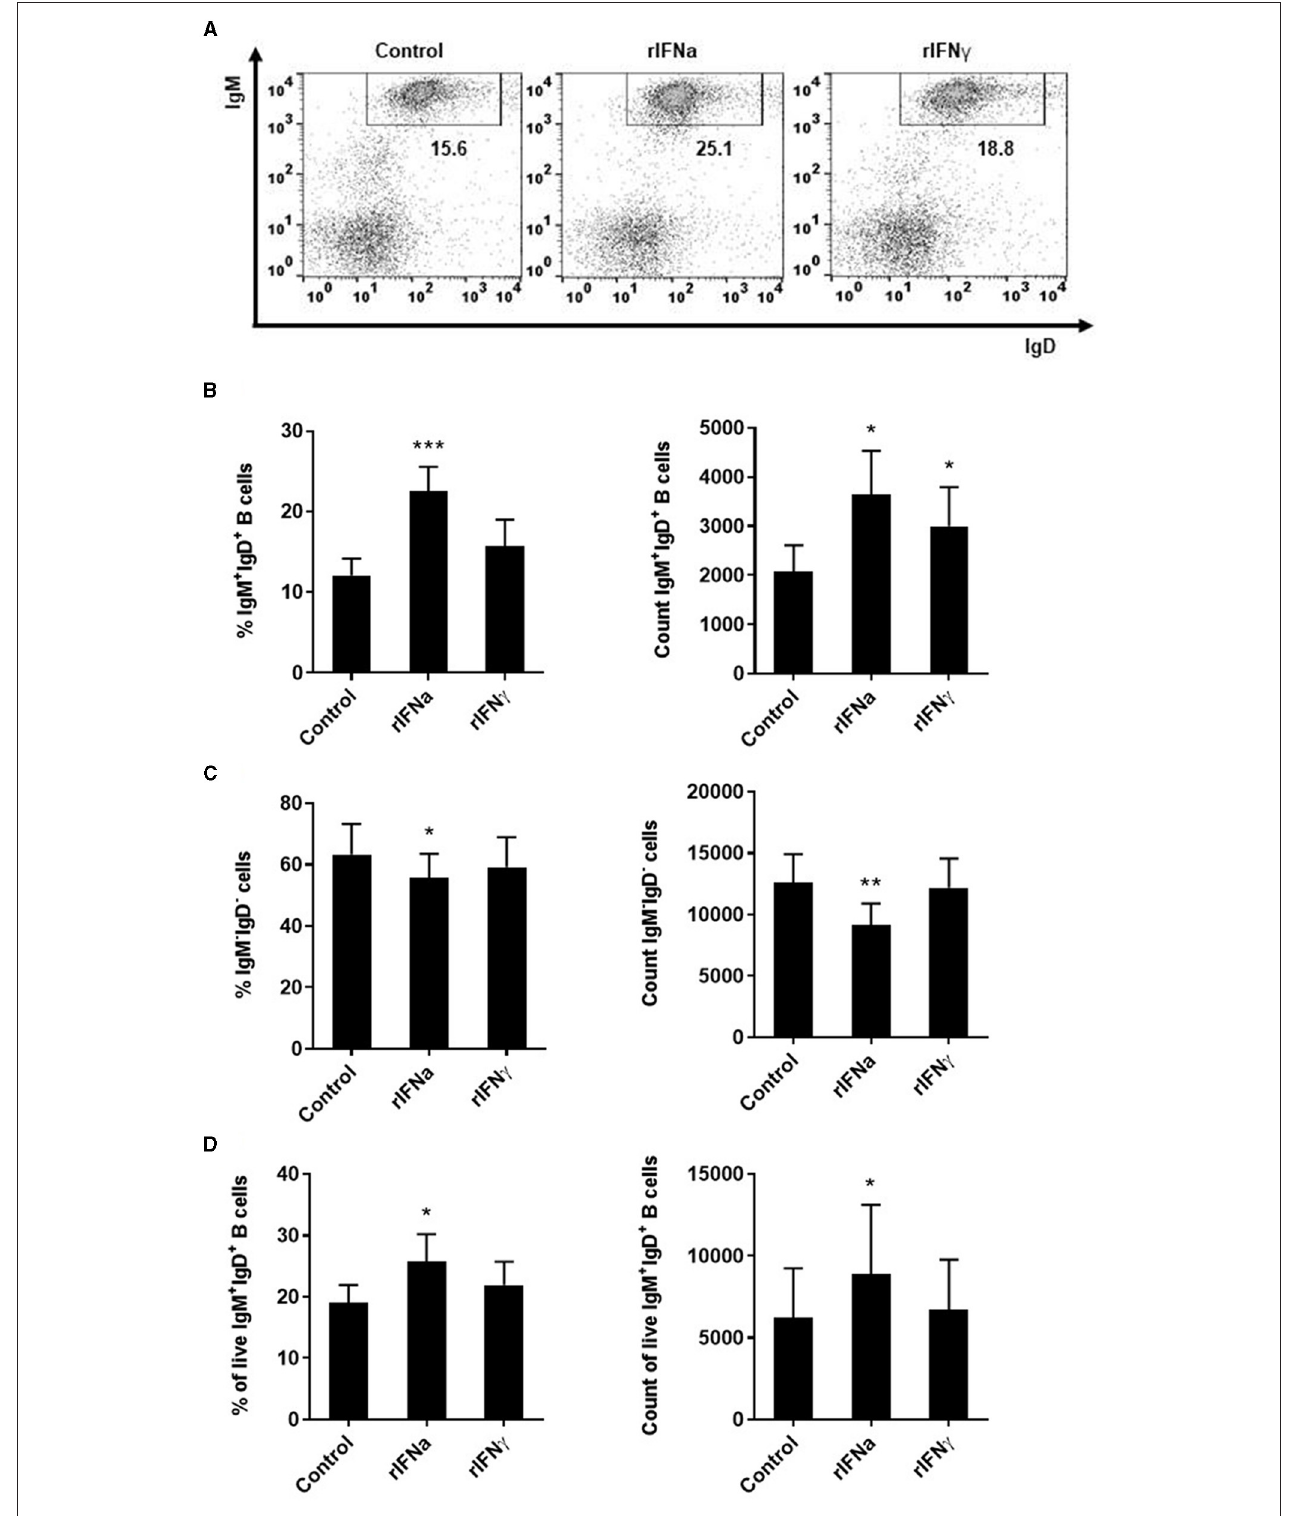
FIGURE 1 | Survival of blood IgM + IgD + B cells in response to type I and type II IFNs. PBLs were stimulated with 50ng/ml rIFNa, 20ng/ml rIFN γ or media alone (control) and cultured at 20 ◦ C for 72h. Leukocytes were then labeled with specific monoclonal antibodies against trout IgM and IgD and analyzed by flow cytometry.